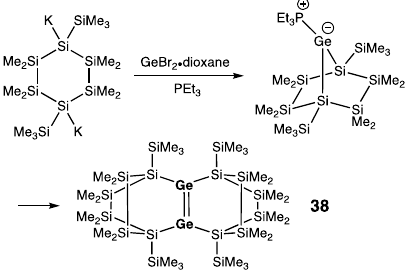
Table 2. X-ray crystallographic parameters of the stable cyclic digermenes. The “ — ” implies lack of the relevant structural information. Cyclic